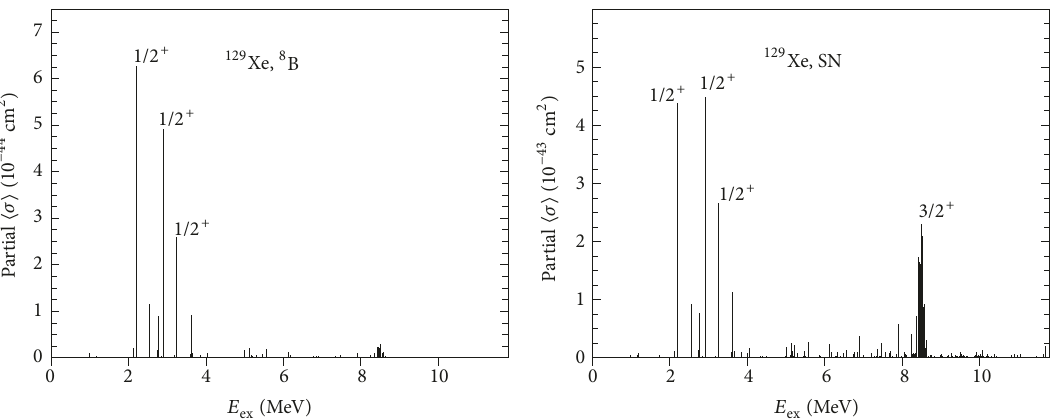
Figure 8: Contributions to the inelastic scattering averaged cross section arising from various final states of 129 Xe at energies 𝐸 shown for 8 B solar neutrinos (left panel) and supernova electron neutrinos (right panel). Cross sections are given in units of 10 −44 cm 2 for solar neutrinos and 10 −43 cm 2 for supernova